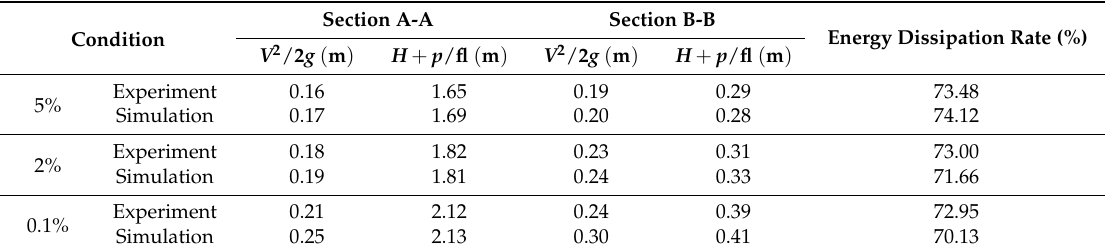
Table 3. The calculation results of the energy dissipation rate.